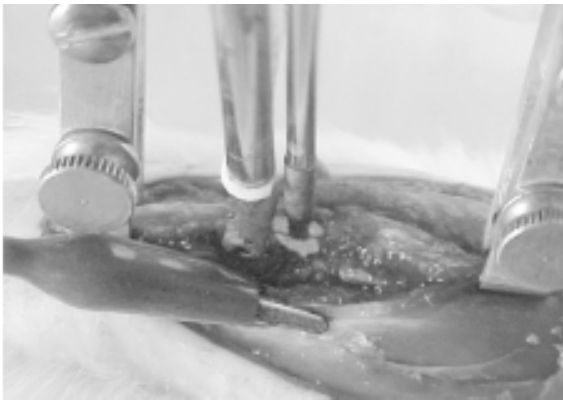
FIGURA 2 - Momento da impacção